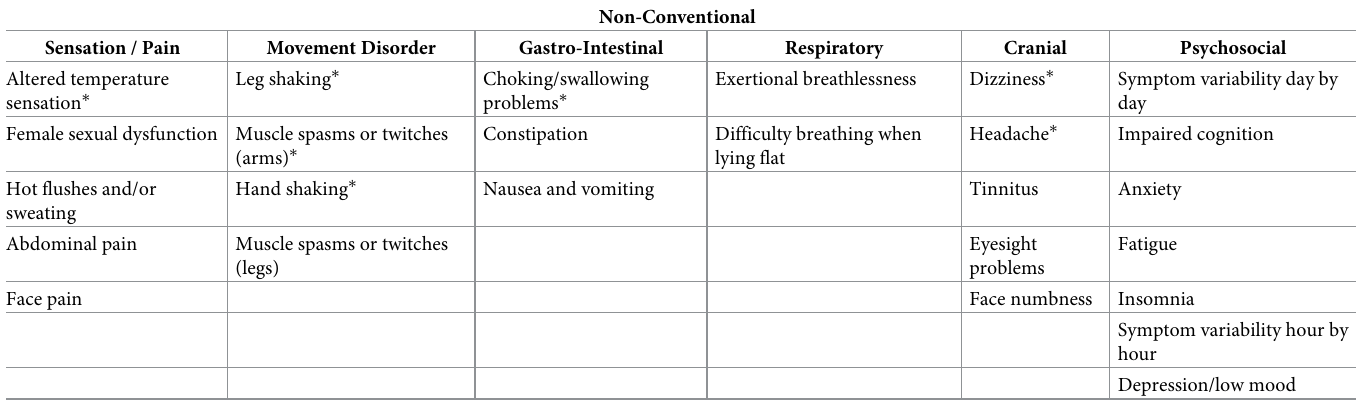
Table 2. Survey symptom classification–non-conventional symptoms.